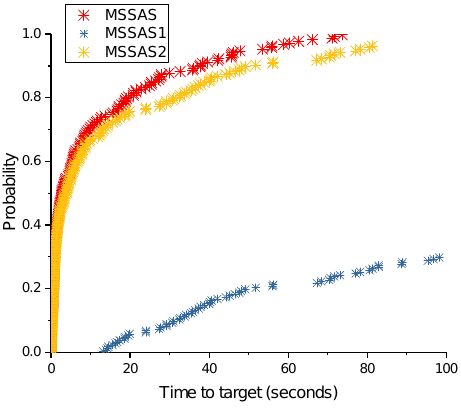
Figure 2. Time-to-target plot comparing MSSAS with MSSAS1 and MSSAS2 on instance C125.9 and its target 512.